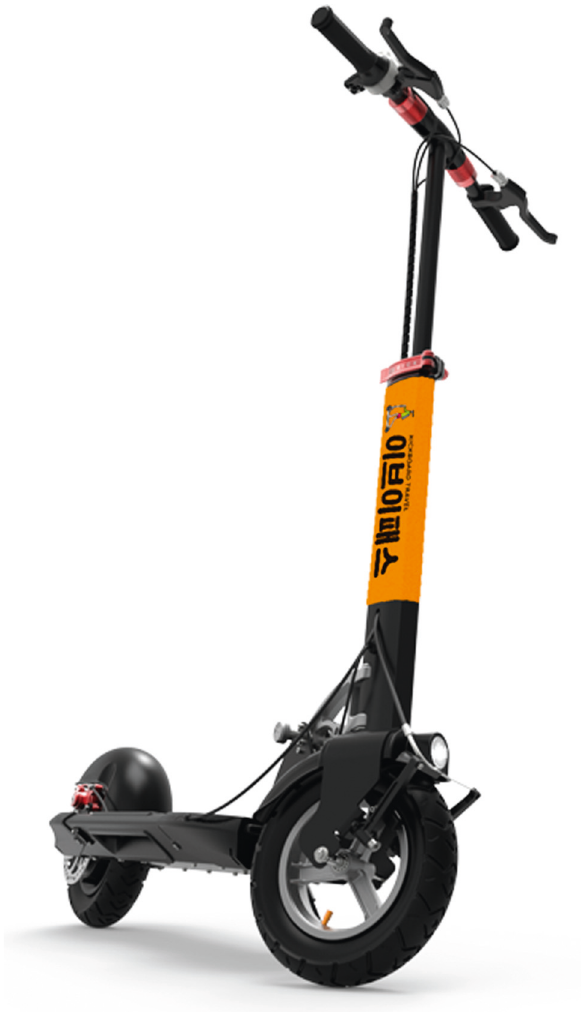
Figure 1: Electric kickboard [2].